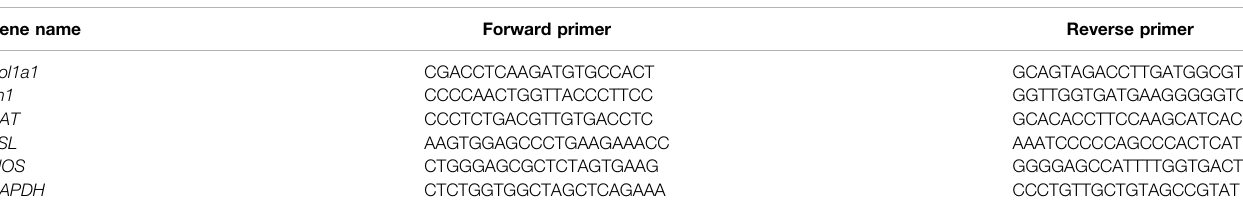
TABLE 2 | Primers used for real-time polymerase chain